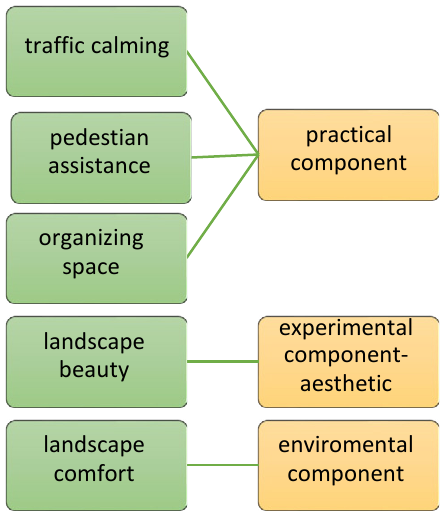
Fig. 2: Components and indicators of urban streets for a humanistic approach (Soltani and Khodaparast, 2010)